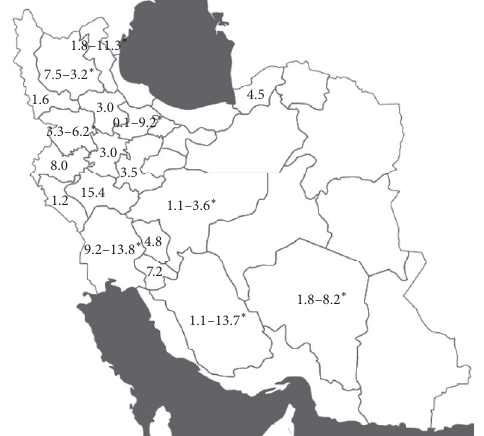
Figure 2: Graphic representation of prevalence (%) of HCE in provinces in Iran. The asterisk ( ∗ ) means the minimum and maximum of prevalence in